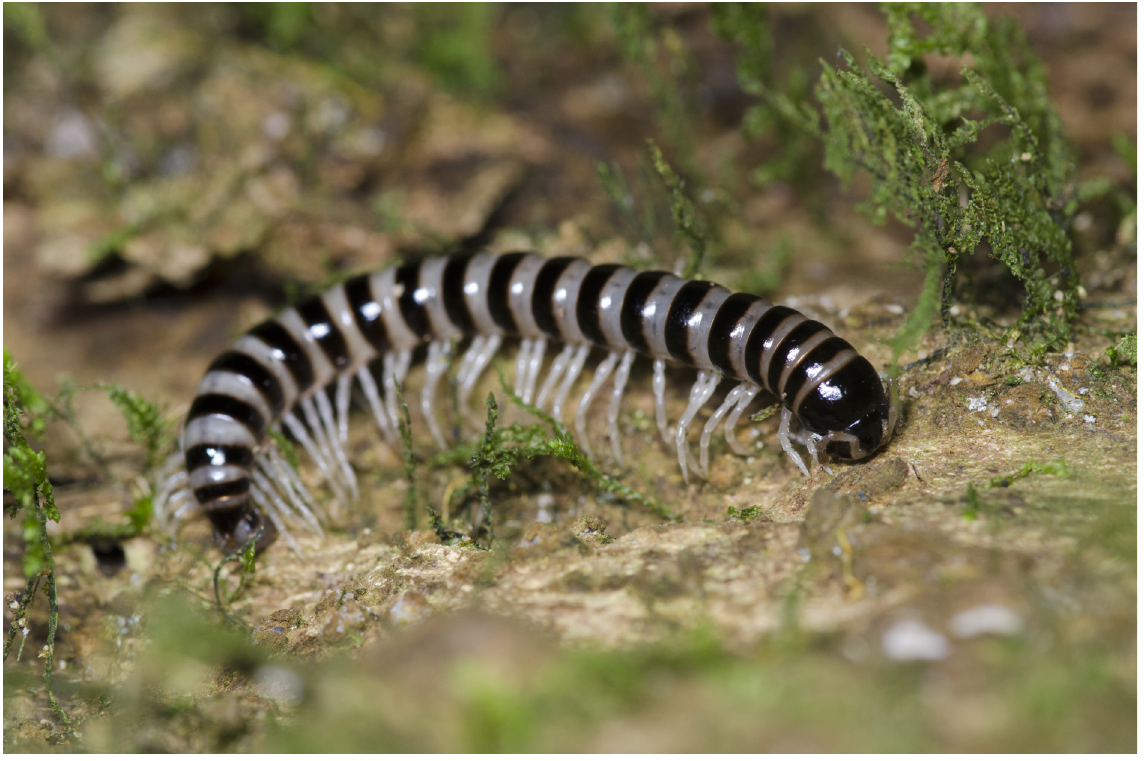
Fig. 1. Eviulisoma zebra sp. nov., one of the strikingly marked species from the Udzungwa Mts. Photograph by Martin